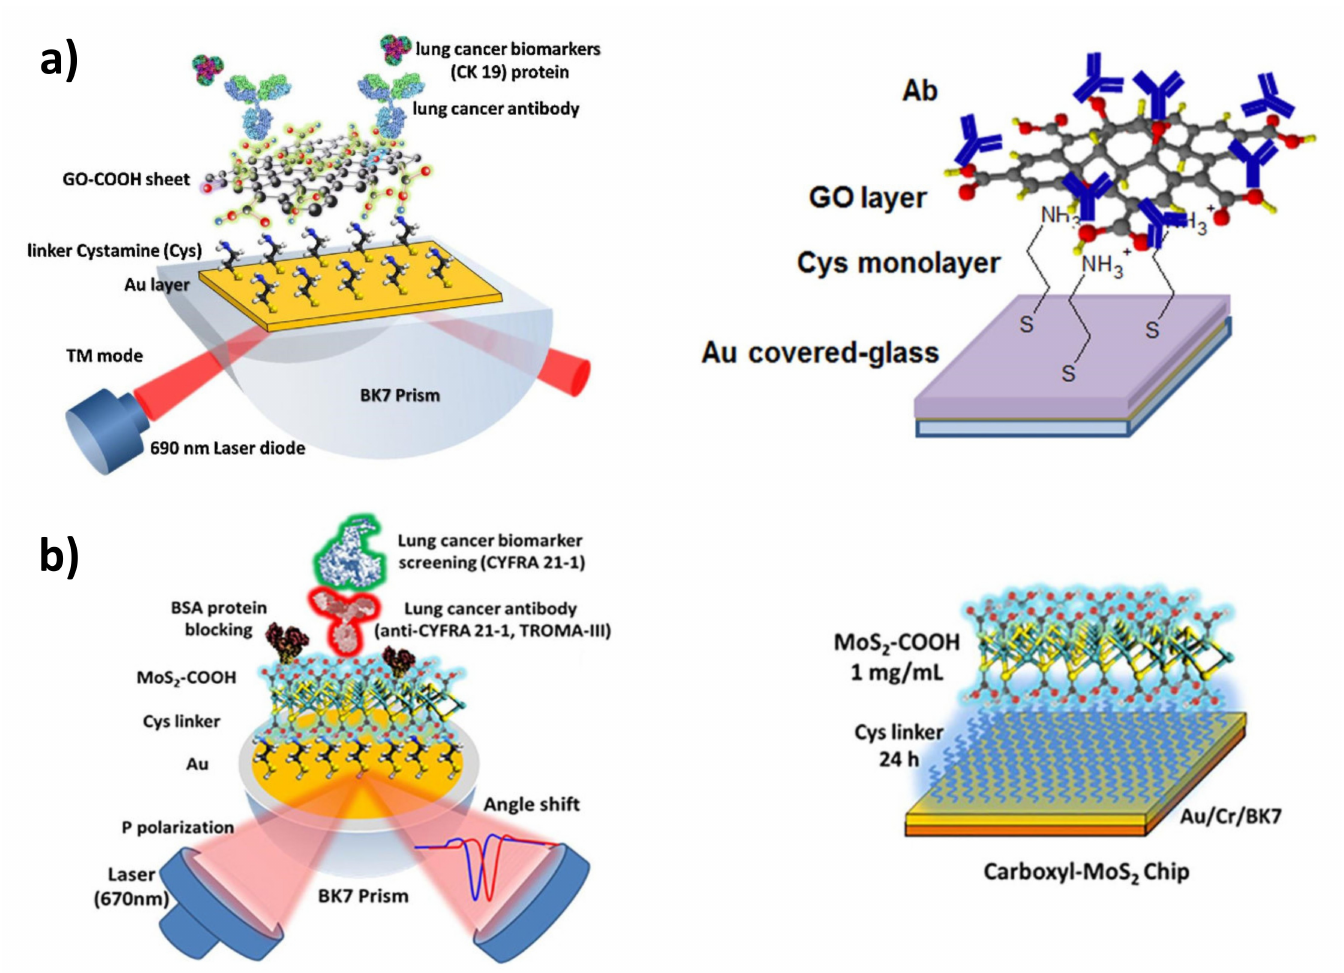
Figure 5. Carboxylated 2D nanomaterial layers as plasmonic enhancers in the construction of SPR immunosensors: ( a ) carboxylated graphene oxide, ( b ) carboxylated MoS2. Adapted with permission from Chiu et al. [98] (Copyright © (2018) Elsevier), Miyazaki et al. [102] (Copyright © (2018) Elsevier), and Chiu and Yang et al. [106] (under the terms and conditions of the Creative Commons CC BY